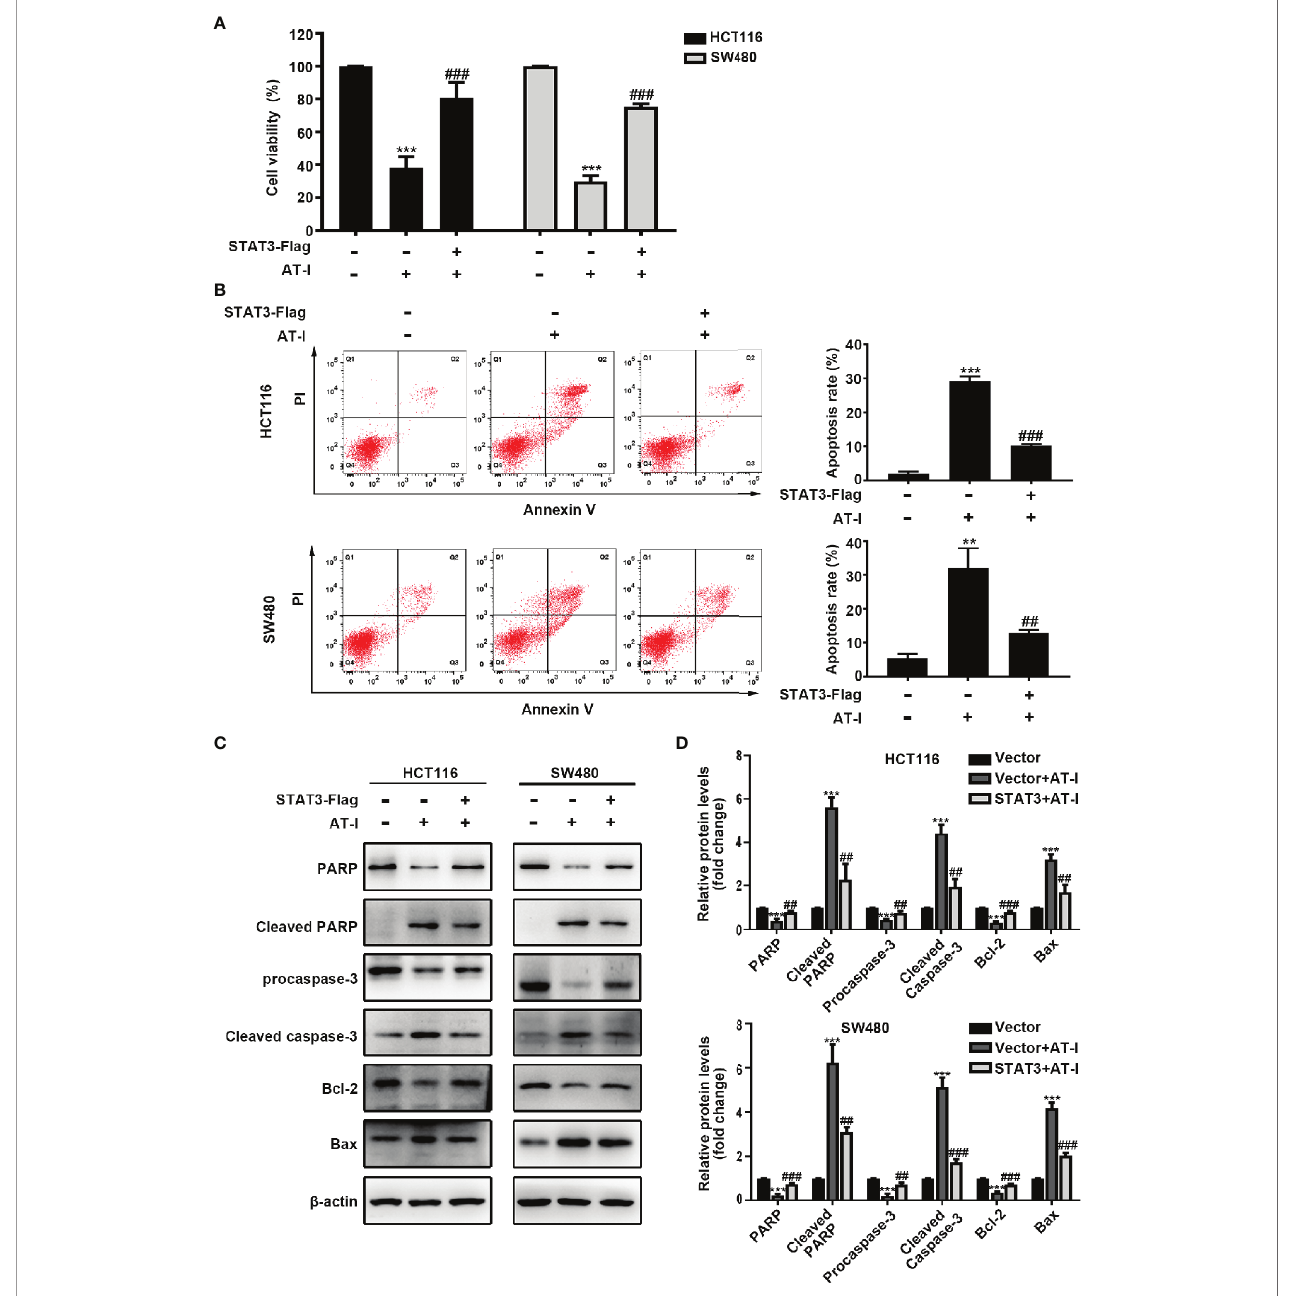
FIGURE 6 | AT-I-induced STAT3 inactivation is involved in its pro-apoptotic activity in CRC cells. The Flag-STAT3 plasmid was transfected into CRC cells, and 48 h post-transfection, these cells were treated with AT-I (200 m M) for a further 24 h. (A) Cell viability determined using the CCK-8 assay. (B) Analysis of apoptosis by Annexin V-FITC/PI double staining. (C) Expression of apoptosis-related proteins detected by western blot analysis. (D) Protein levels were normalized to those of b - actin, and these are shown as fold changes relative to the control group levels. Data are shown as the mean ± SD of three independent experiments. ** p < 0.01 and *** p < 0.001 compared with the control group without any treatment. ## p < 0.01 and ### p < 0.001 compared with the AT-I-treated